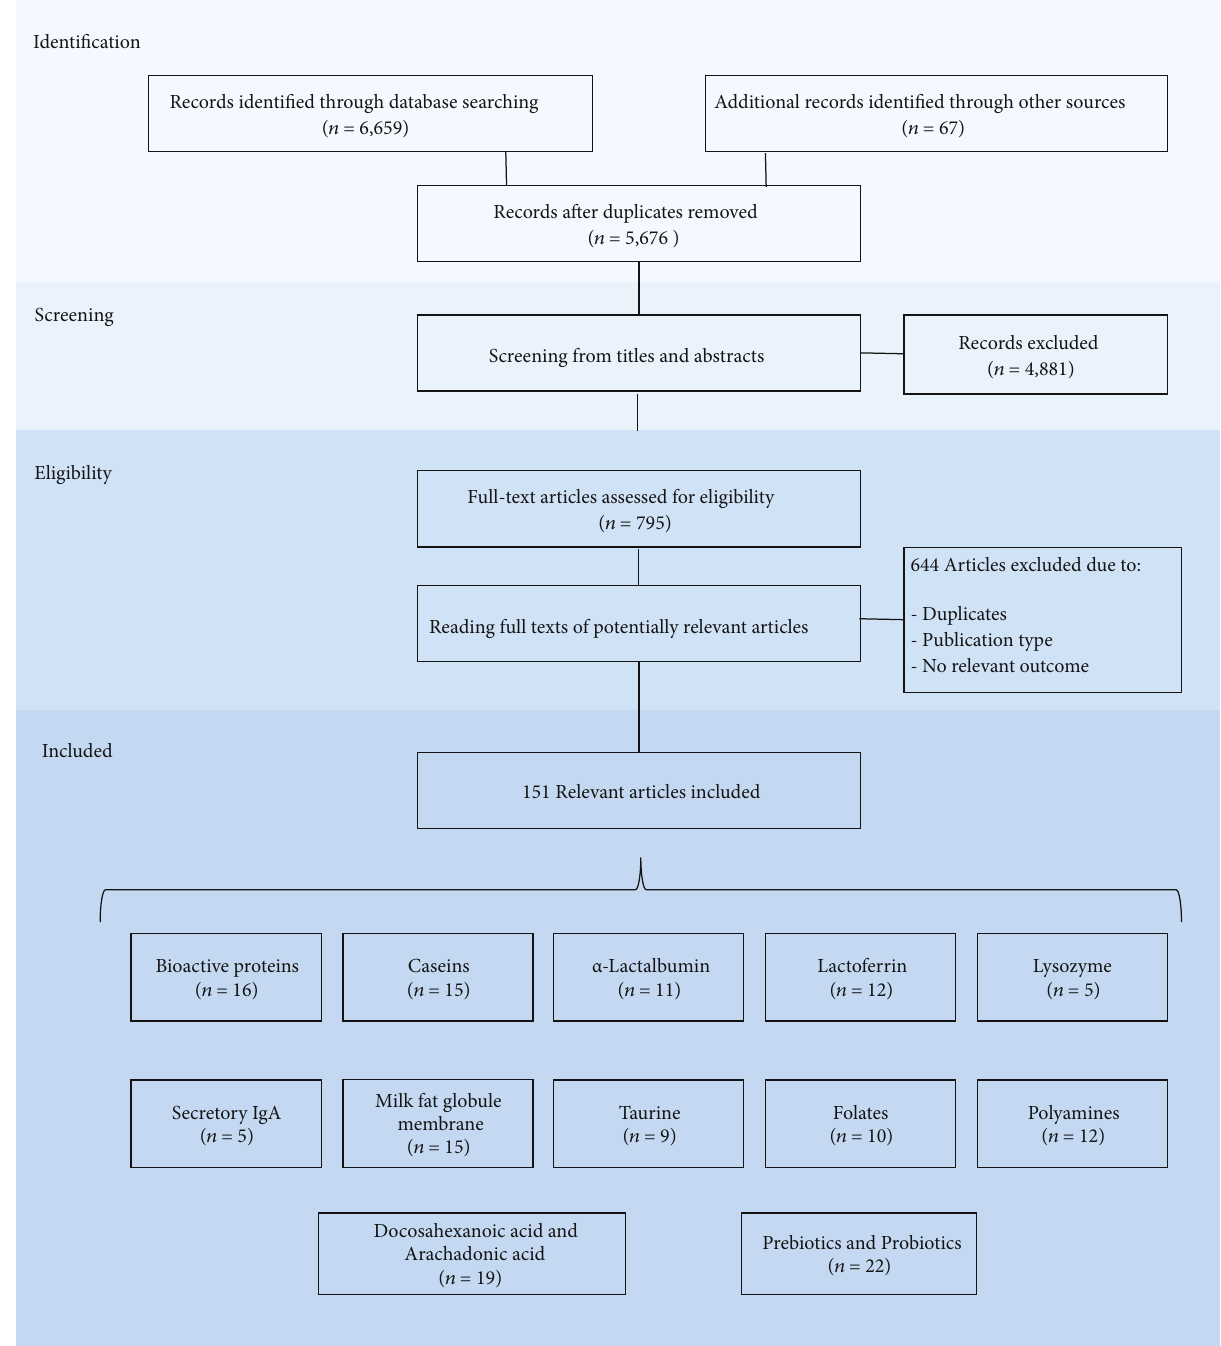
Figure 1: PRISMA fl owchart of the processes followed in composing the systematic